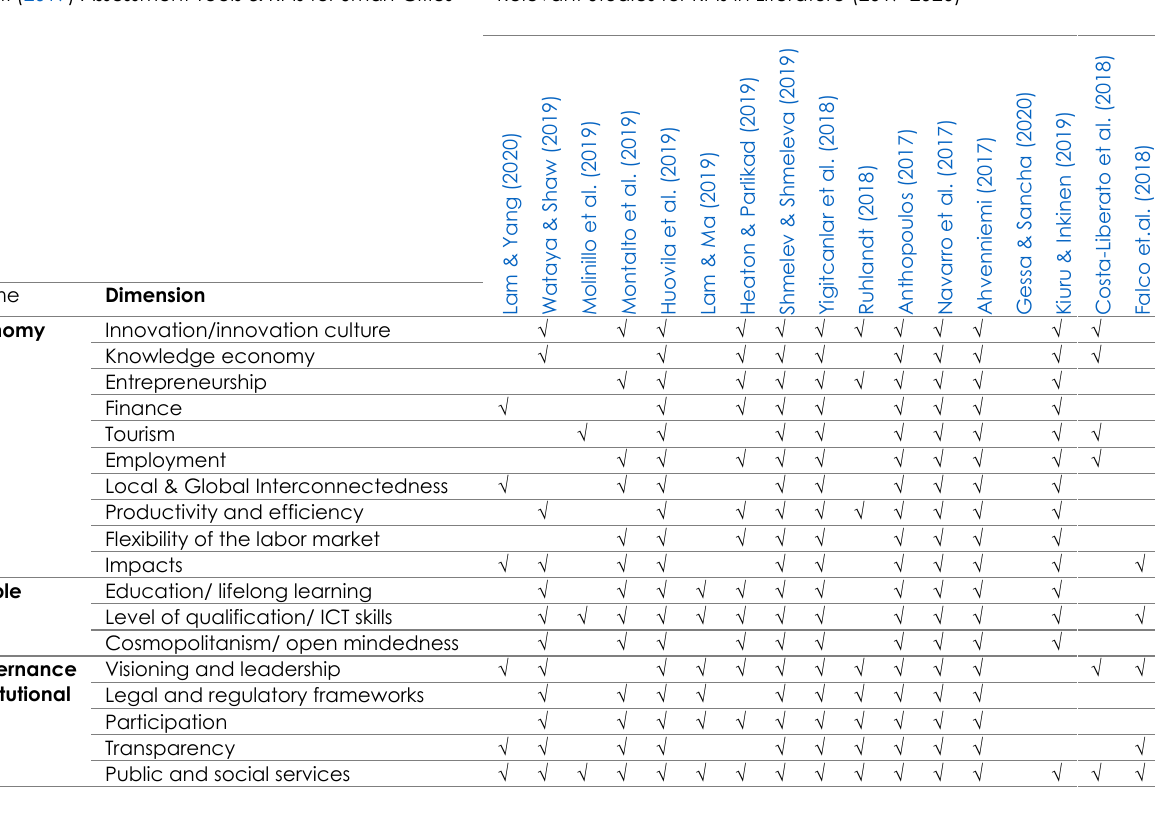
Table 3. Themes and Sub-themes of the reviewed papers on Urban Literature. Sharifi (2019) Assessment Tools & KPIs for Smart